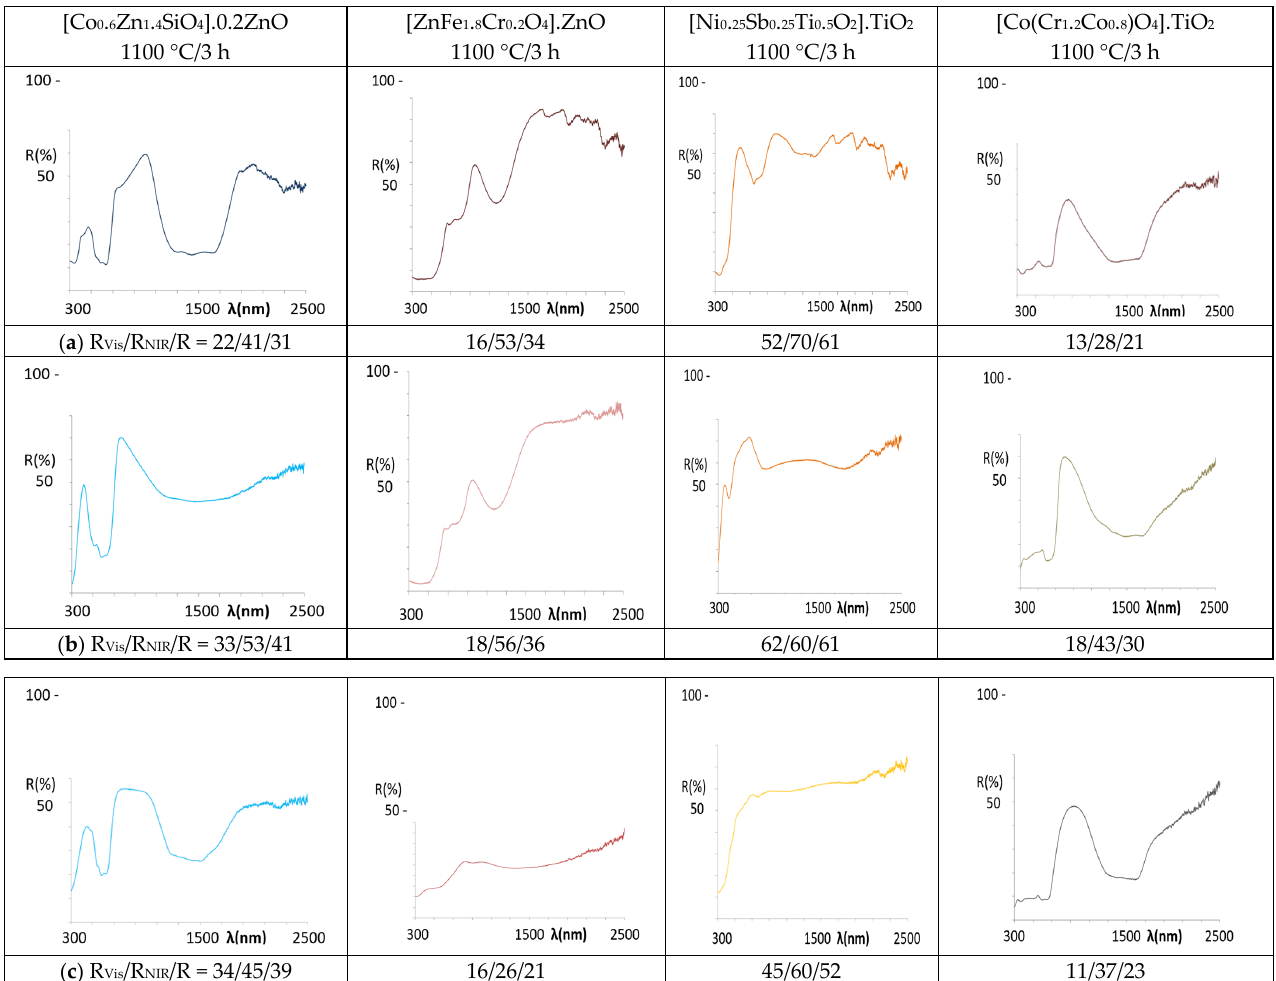
Figure 11. UV-Vis-NIR reflectance spectra of rare earth pigment applications: ( a ) 10 wt.% in colour- less alkyd paint, ( b ) 3 wt.% in double firing frit (1000 °C), ( c ) 2% wt.% in porcelain powder (1190 °C).